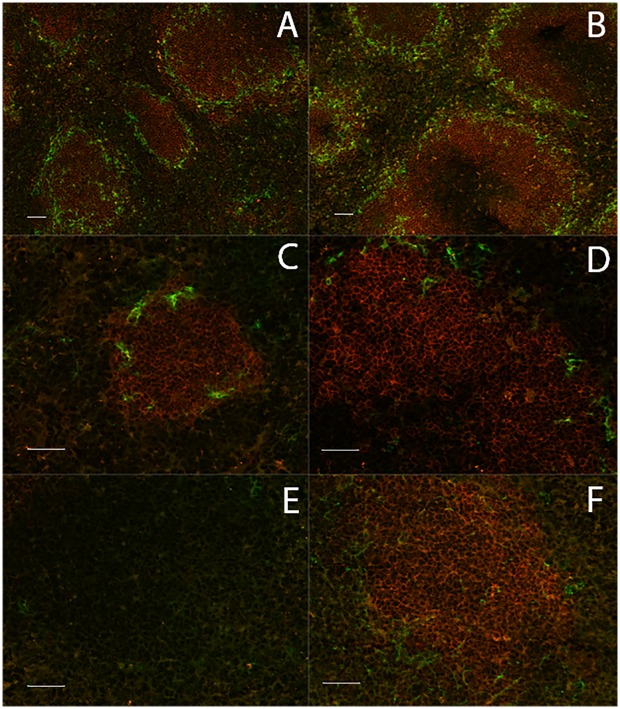
Distribution of B220+ and MOMA+ cells in spleens of intact and Prf1
-/- mice infected with T. brucei AnTat 1.1.Thin sections (10 μm) of OCT embedded frozen mouse spleens, were air dried, fixed in acetone, rehydrated and stained with anti-B220 (red) to detect B cells and anti-MOMA (green) to detect marginal metallophilic macrophages. The slides were stained and read on the same day on a Zeiss MOT200 inverted microscope with a Zeiss apotome at 20x magnification. Scale bars, 50 micrometers. (A) Uninfected C57BL/6 mice, (B) uninfected Prf1
-/- C57BL/6 mice, (C, E) C57BL/6 mice infected for 10 and 30 days with T. brucei AnTat 1.1, (D, F)
Prf1
-/- C57BL/6 mice infected for 10 and 30 days with T. brucei AnTat 1.1. Results are representative of 5 mice studied in each group.